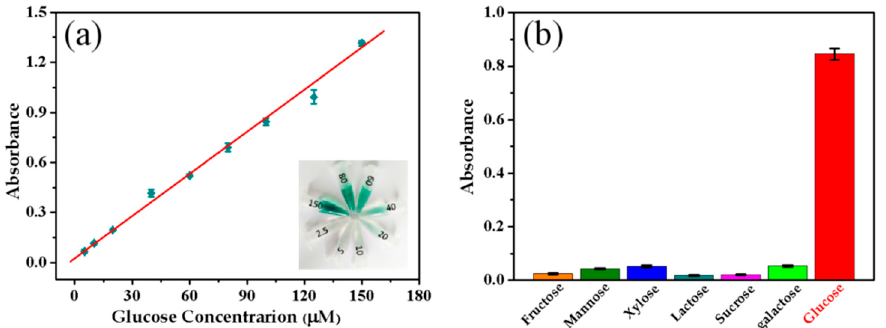
Figure 7. ( a ) Linear correlation for glucose (2.5–150 µM) detection; ( b ) Selectivityfor glucose (100 µM) detection with interfering compounds (1.0 mM offructose, mannose, xylose, lactose, galactose, sucrose, and galactose).